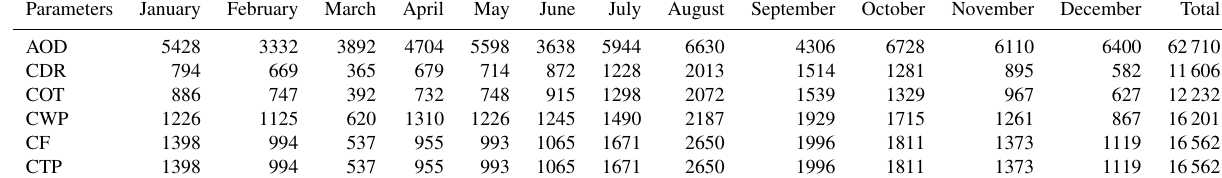
Table 2. The sample sizes of all months for each parameter. Parameters